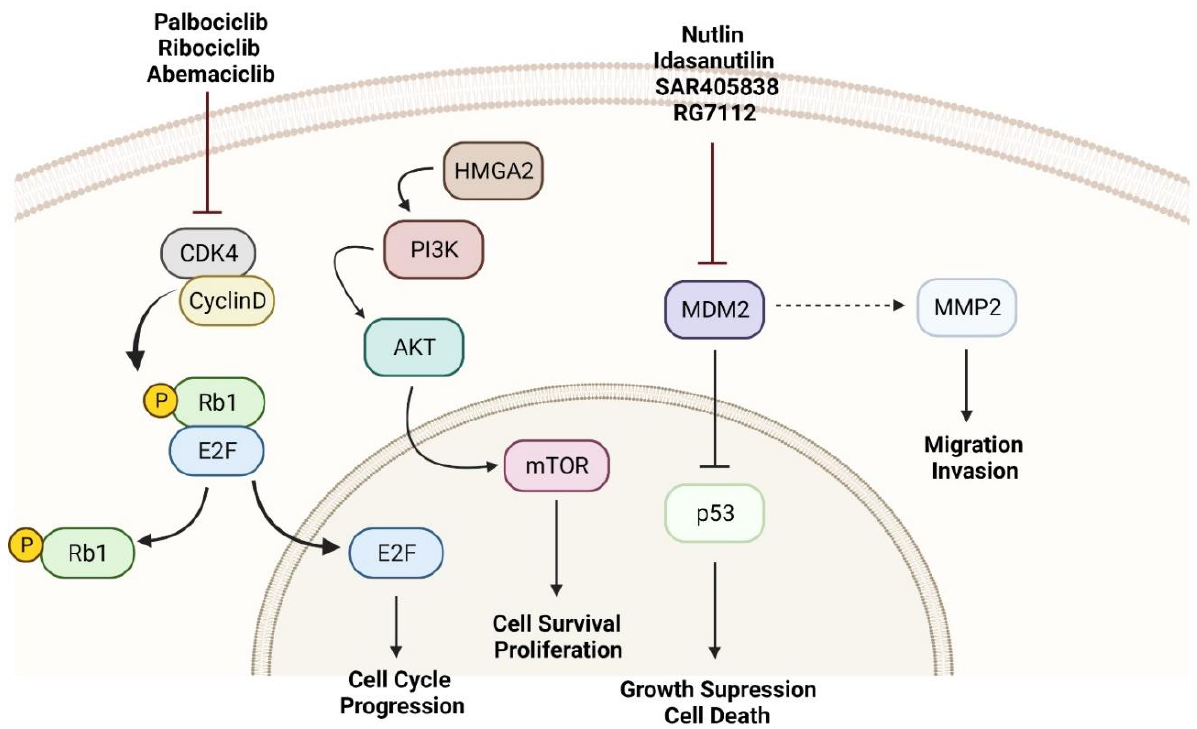
Figure 1. Target pathways on WD/DDLPS treatment. MDM2, CDK4, and HMGA2 amplification promote cell survival, proliferation, and metastatic phenotype in RPLPS. These pathways could be considered as targeted therapies for WD/DDLPS treatment.